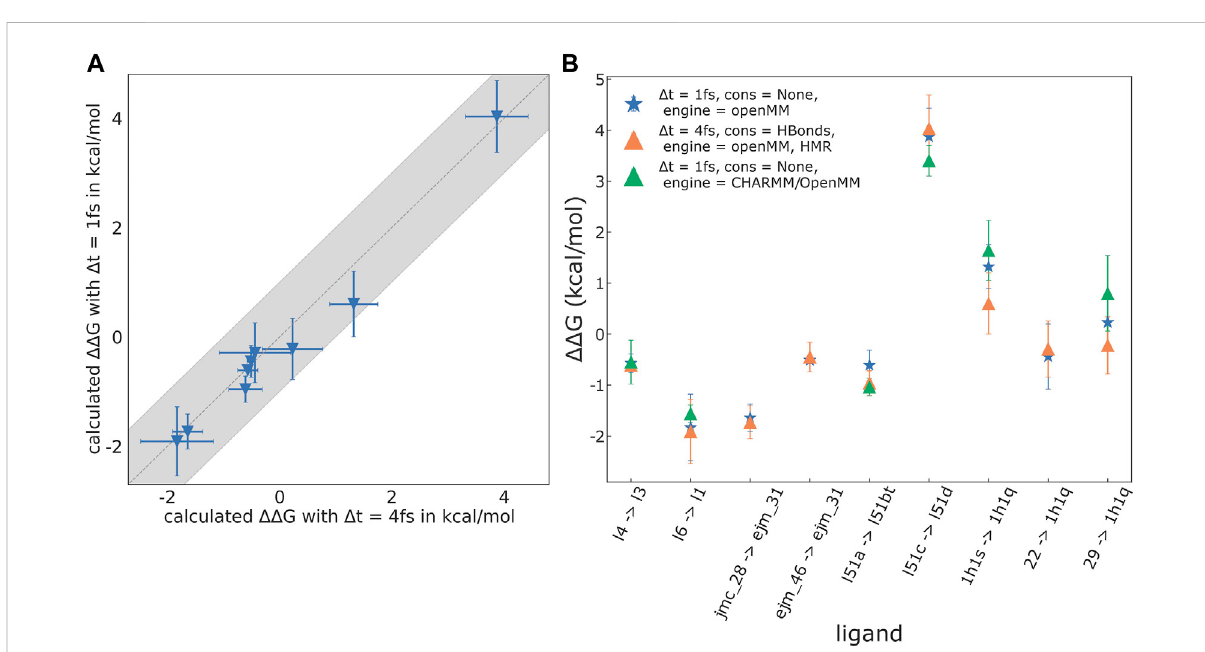
FIGURE 5 Results for selected mutations recomputed without HMR, using OpenMM, as well as CHARMM/OpenMM as the underlying MD engine. The reduced set consists of: GAL3, l4 → l3, l6 → l1; TYK2, jmc_28 → ejm_31, ejm_46 → ejm_31; FXa, l51a → l51d, l51c → l51bt; CDK2, 1h1s → 1h1q, 22 → 1h1q,29 → 1h1q. (A) PlotofresultscalculatedwithoutHMR(timestep Δ t =1 fs,noconstraintsontheligandandprotein)againstresultswithHMR( Δ t = 4 fs, constraints on allbondsinvolvinghydrogenatoms).Fortheselected mutations RMSE( ΔΔ G bind )= 0.30 kcal/mol,MAE ( ΔΔ G bind )=0.21 kcal/ results for the mutations of the subset obtained with OpenMM with and mol, Pearson ’ s R = 0.99, and Spearman ’ s ρ = 1.0. (B) Plot of the ΔΔ G bind L 1 → L 2 without HMR, as well as CHARMM/OpenMM (no HMR). For the results without HMR, using OpenMM and CHARMM/OpenMM as the